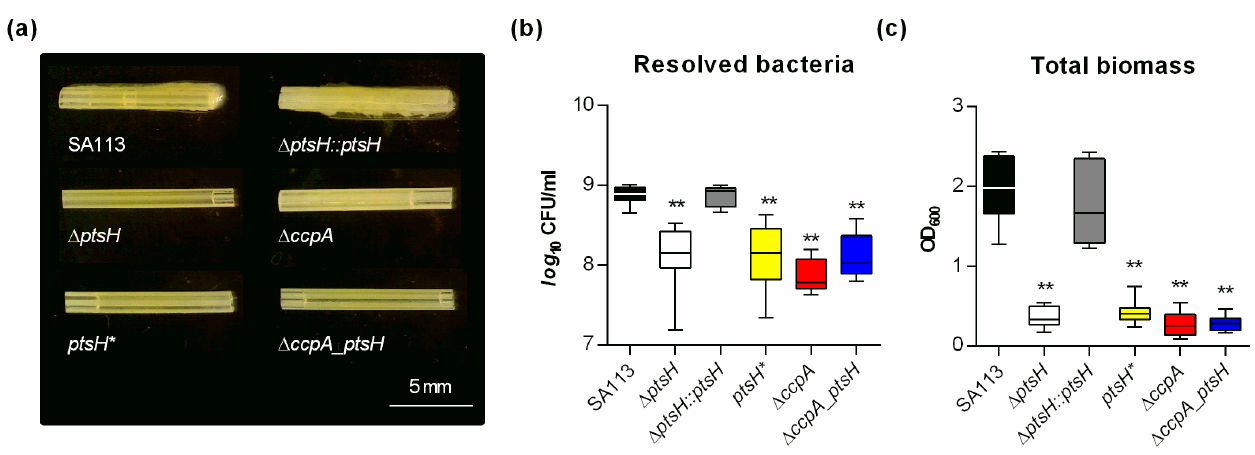
Figure 5. Inactivation of ptsH and/or ccpA reduces the biofilm formation capacity of S. aureus on medical devices. ( a ) Images of S. aureus -loaded catheter fragments at day 5 post inoculation (6.3-fold magnification). The results are representative of three independent experiments. ( b , c ) Colony forming units (CFU) and total biomass of detached biofilms were determined by plate counting ( b ) and measuring the OD 600 of the TSB solutions ( c ). The data are presented as box and whisker plot showing the interquartile range (25–75%, box), the median (horizontal line), and the standard deviation (bars) of nine independent experiments. **, p < 0.01 (one-way ANOVA and Holm-Sidak’s multiple comparison test; only differences between SA113 and mutants are